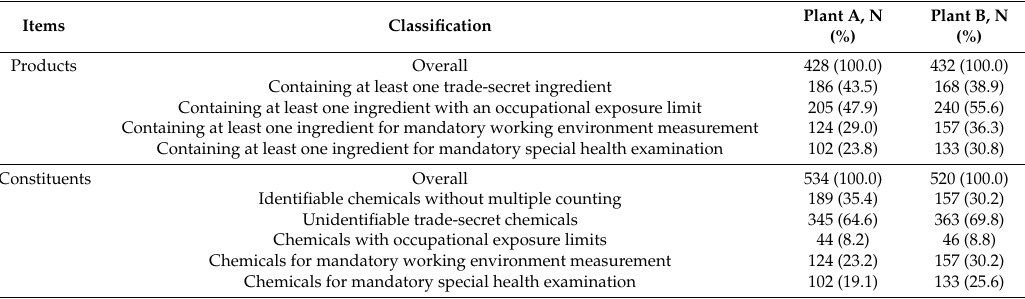
Table 2. Characteristics of chemical products and constituents used in plants A and